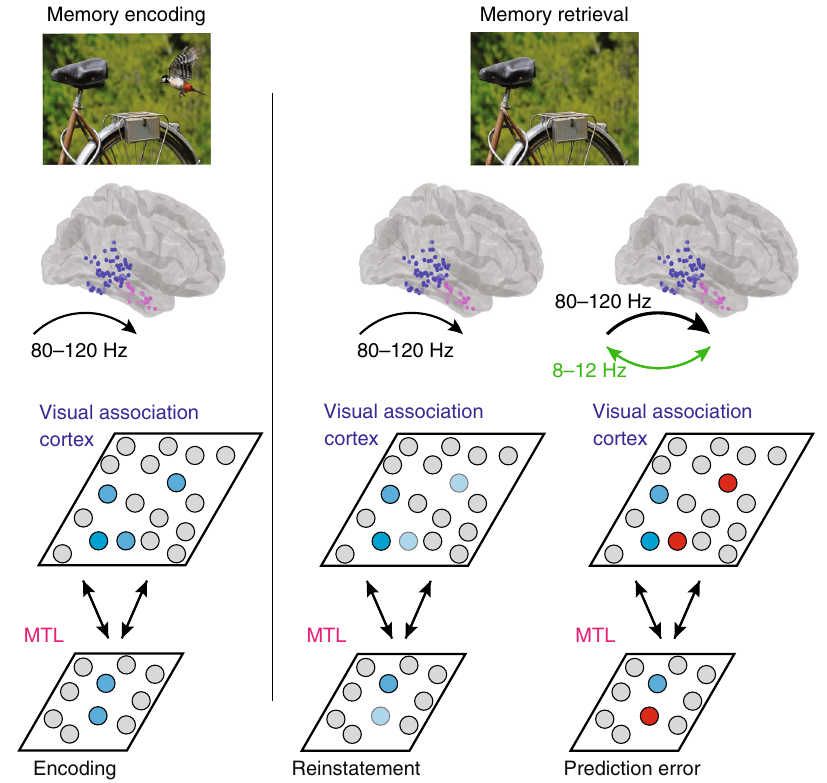
Fig. 7 Model of cortical – medial temporal lobe interactions during visuospatial recognition. Initially viewing an image evokes image-speci fi c 80 – 120 Hz activity within the visual association cortex and medial temporal lobe (MTL; blue units). During successful memory retrieval, the neural representation of a previously encoded image is reinstated within the visual association cortex and MTL. Successful reinstatement of this past experience is compared to current visual experience (dark and light blue units). In this case, the present visual experience no longer contains the bird that was in the remembered past visual experience. Any differences between present and past visual experience evoke an increase in 80 – 120 Hz power (bold arrow), which re fl ects an error signal, that arises in visual association cortex and propagates to the MTL (red units). This error signal is accompanied by low frequency coherence between these brain regions